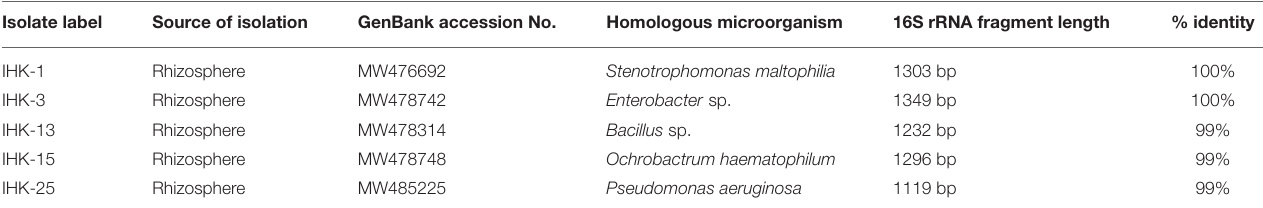
TABLE 5 | Identification of efficient diazotrophic PGP bacterial isolates by 16S rRNA gene sequencing analysis. Isolate